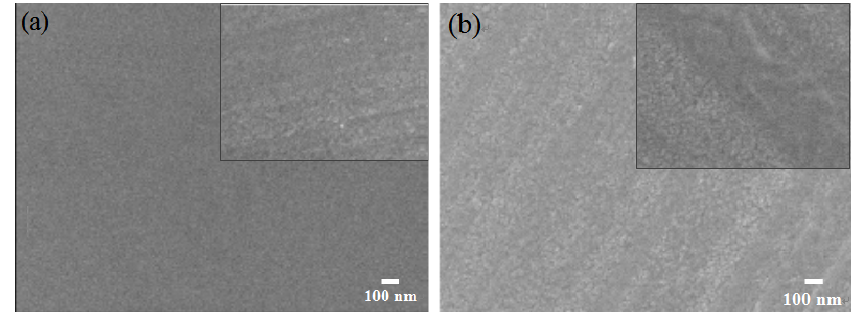
Figure 6. Surface images of ( a ) as-deposited AZO thin film and ( b ) as-deposited 1.2 at.% Mg-doped AZO film; inset shows the surface morphology of the respective film post-annealed at 600 °C.